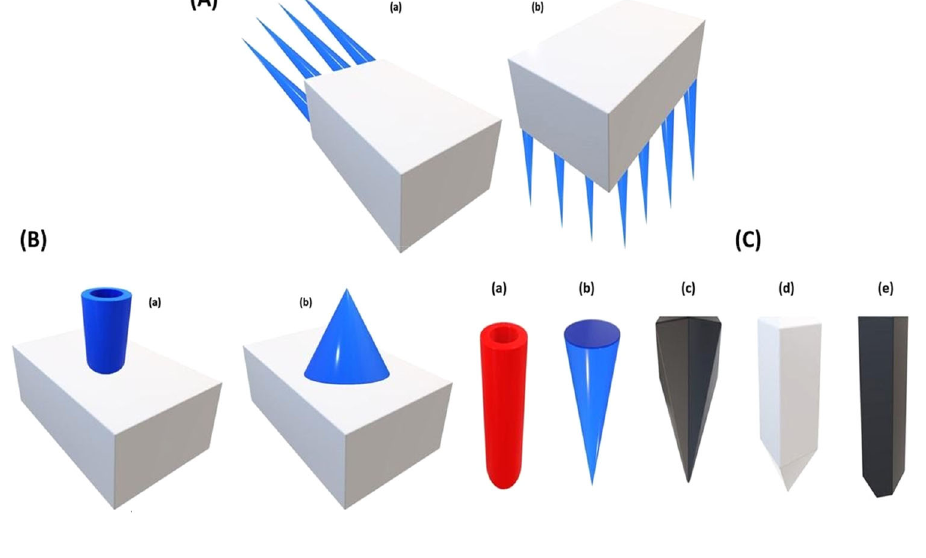
Fig. 5 Different types of MNs according to the drug delivery approaches a solid, b coated, c dissolving, d hollow, and e hydrogel-forming